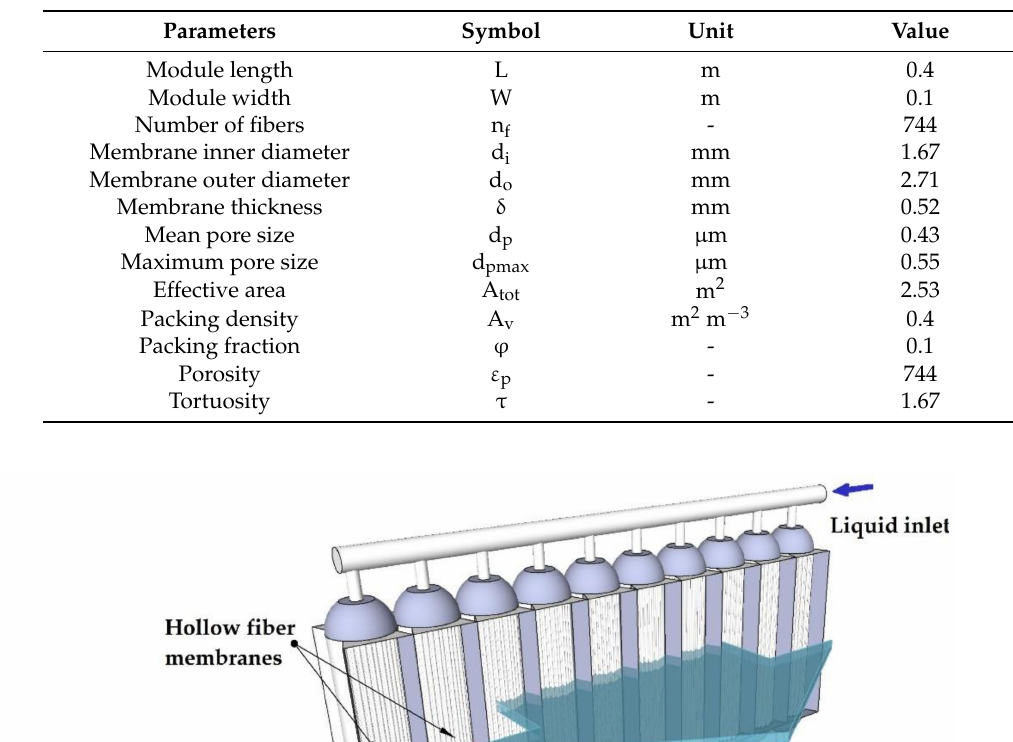
Table 1. Geometric parameters of the single hollow-fiber membrane module.